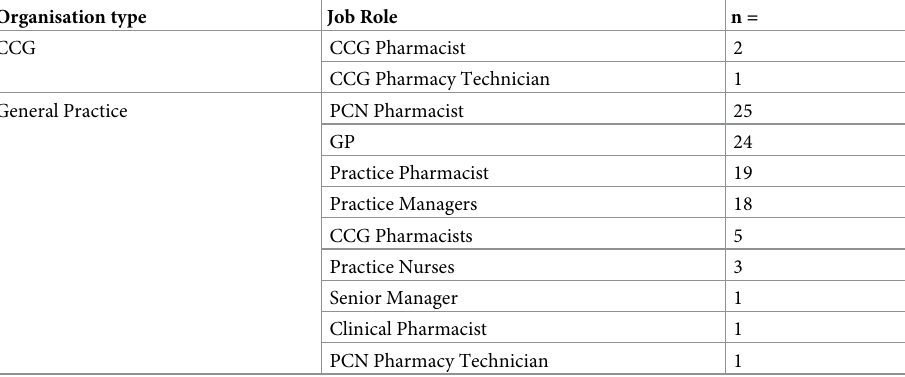
Table 4. Survey respondent